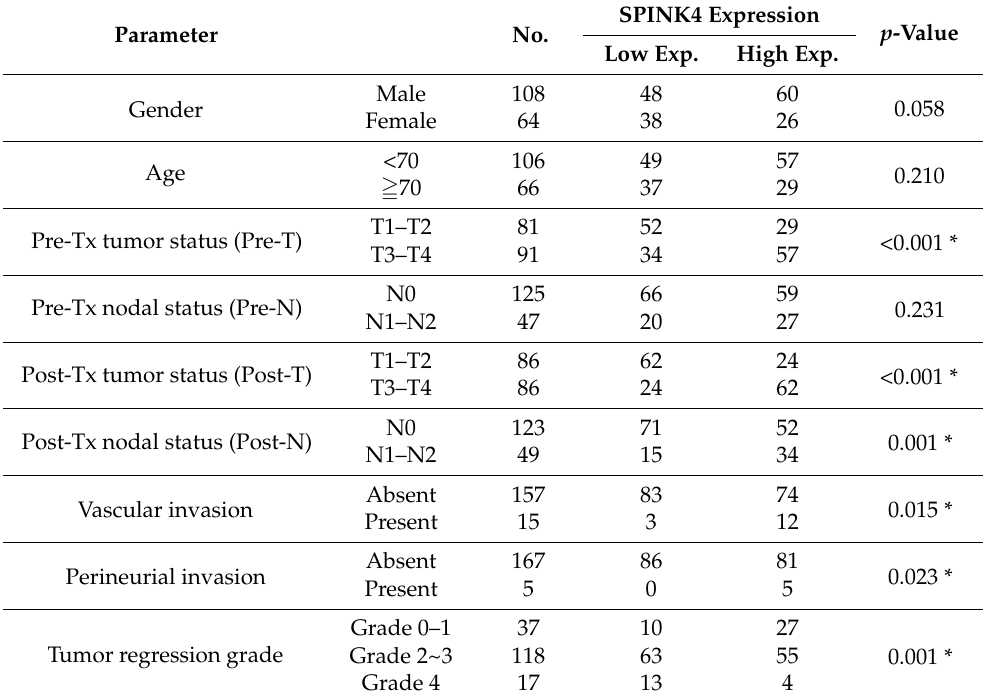
Table 2. Correlations between SPINK4 expression and clinicopathological features in 172 rectal cancer patients receiving neoadjuvant CCRT.